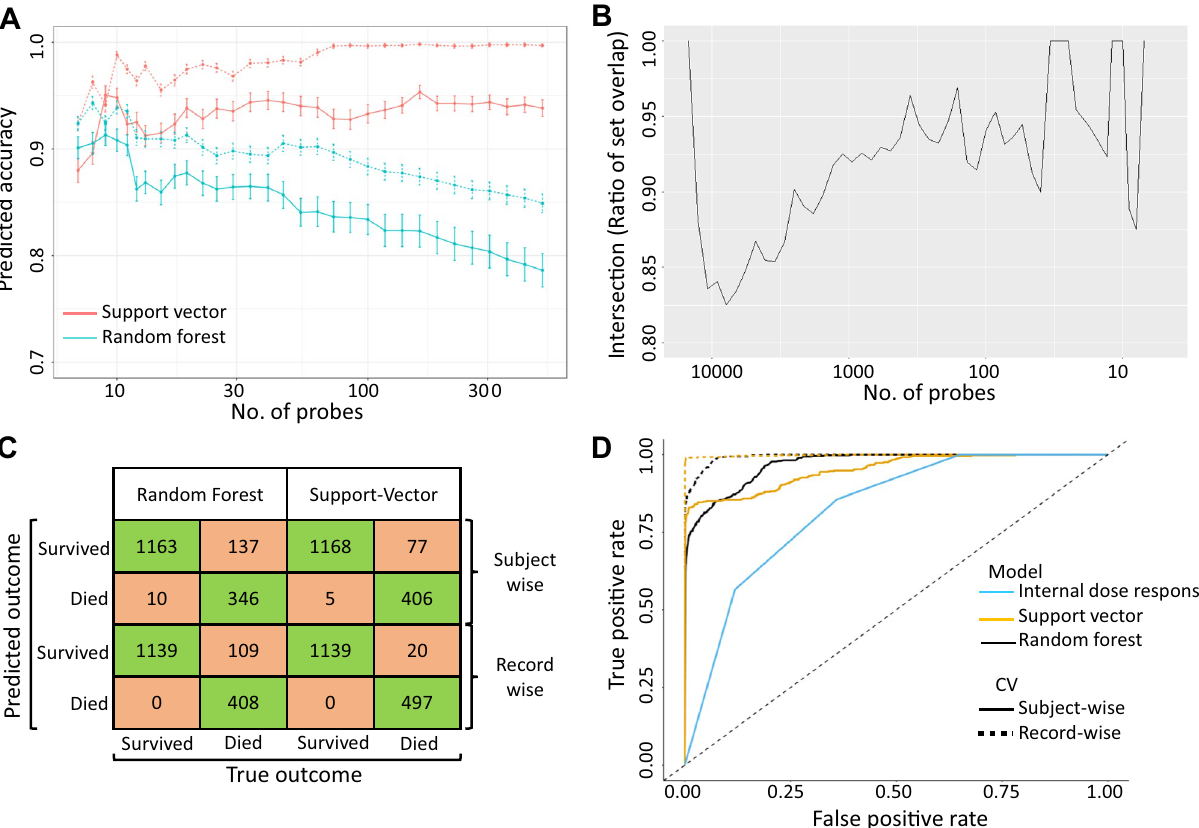
Figure 6. Identification of survival-predictive gene expression signatures using machine learning algorithms. ( A ) Accuracy as a function of the number of genes in the model. Genes were selected by recursive feature elimination (RFE) procedure. Solid and dashed curves are accuracy estimates based on subject-wise and record wise cross-validation procedures, respectively. The blue curves show accuracy of the random forest models that were used in the RFE. The red curves show accuracy estimates for a radial kernel support vector machine using the same genes from the random forest-based RFE. ( B ) Plot showing percent intersection of RFE selected genes between the record-wise and subject-wise cross-validation models across models with varying numbers of genes. ( C ) Confusion matrices based on the most accurate random forest and support vector machine classifier within each cross-validation procedure. Values in the cells show the frequency with which predicted outcomes overlapped with true outcomes. The frequency values were pooled across all 276 individual splits used during the cross-validation procedure; 276 splits each containing 6 observations in the test set result in 1,656 total predictions made. Green colored cells are correct predictions, while orange colored cells are wrongly predicted outcomes ( D ) ROC curves for each model and cross-validation procedure compared to the traditional dose– response. The true positive rate is plotted as a function of the false positive rate, based on a varying threshold for predicting survival status; a positive label corresponds to an outcome/prediction of death. The ROC curves were built using the most accurate model for each classifier and cross-validation procedure. The dose–response was assumed to be a monotonic univariate function of dose, such as a logistic or probit regression model. Only four doses were used in this experiment and, given a threshold probability value, all subjects at that dose would have the same prediction using a dose–response model. Therefore, any dose–response model would have the same ROC curve in this data set. Solid and dashed lines correspond to subject-wise and record-wise cross-validations, respectively. Black and orange lines correspond to Random Forest and Support Vector based classifier, respectively. Blue line represents dose-predictive model and dashed line at 45° represents the random